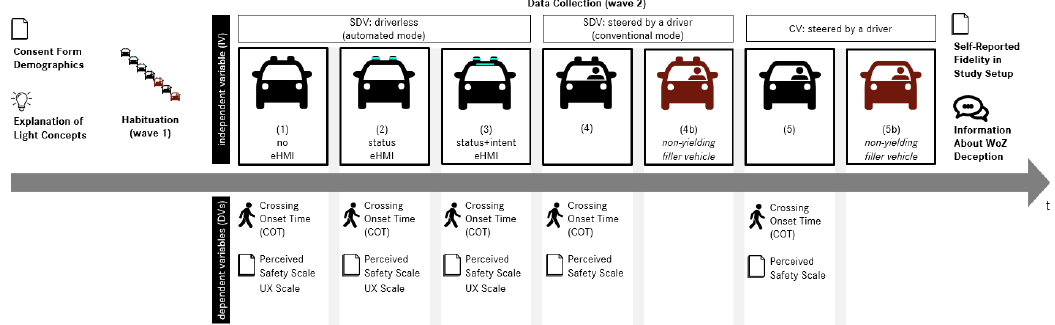
Figure 1. Procedure. The top row represents the study flow and the independent variable (IV). The driverless self-driving vehicle (SDV) (automated mode) is equipped with no eHMI, status eHMI or status + intent eHMI (test conditions 1, 2, 3). Both the SDV steered by a driver (conventional mode) and the conventional vehicle (CV) are either yielding (test conditions 4, 5) or non-yielding (filler test conditions 4b, 5b). In a randomized order, each participant experienced all seven test conditions once for habituation (wave 1) and once for data collection (wave 2). The bottom row represents the dependent variables (DVs) assessed in wave 2. The crossing onset time (COT) data were recorded by an Arduino Uno through the logs of two force-sensitive resistor sensors. For the subjective measures, participants filled in questionnaires after each trial. While perceived safety was measured for all yielding vehicle trials, we applied the user experience scales only after trials with a driverless SDV. Reproduced with permission from Faas, Kao and Baumann, A longitudinal video study on communicating status